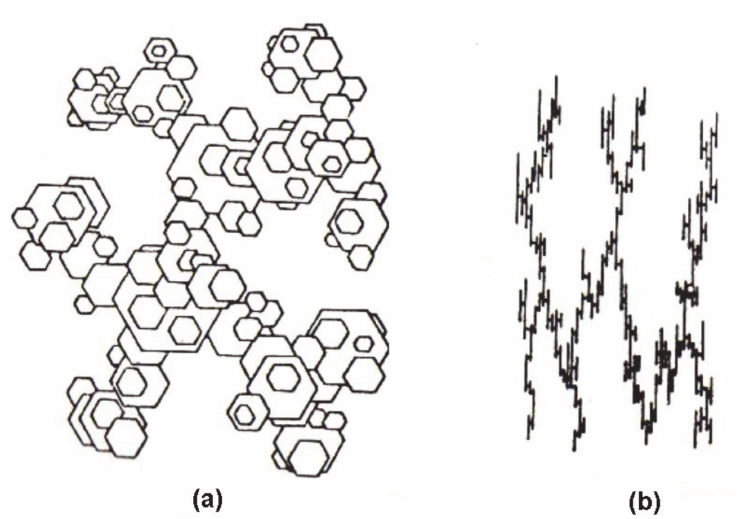
Figure 1. Scheme of the foliate dendrites proposed by Saratovkin [10]: ( a ) in plane; ( b ) in